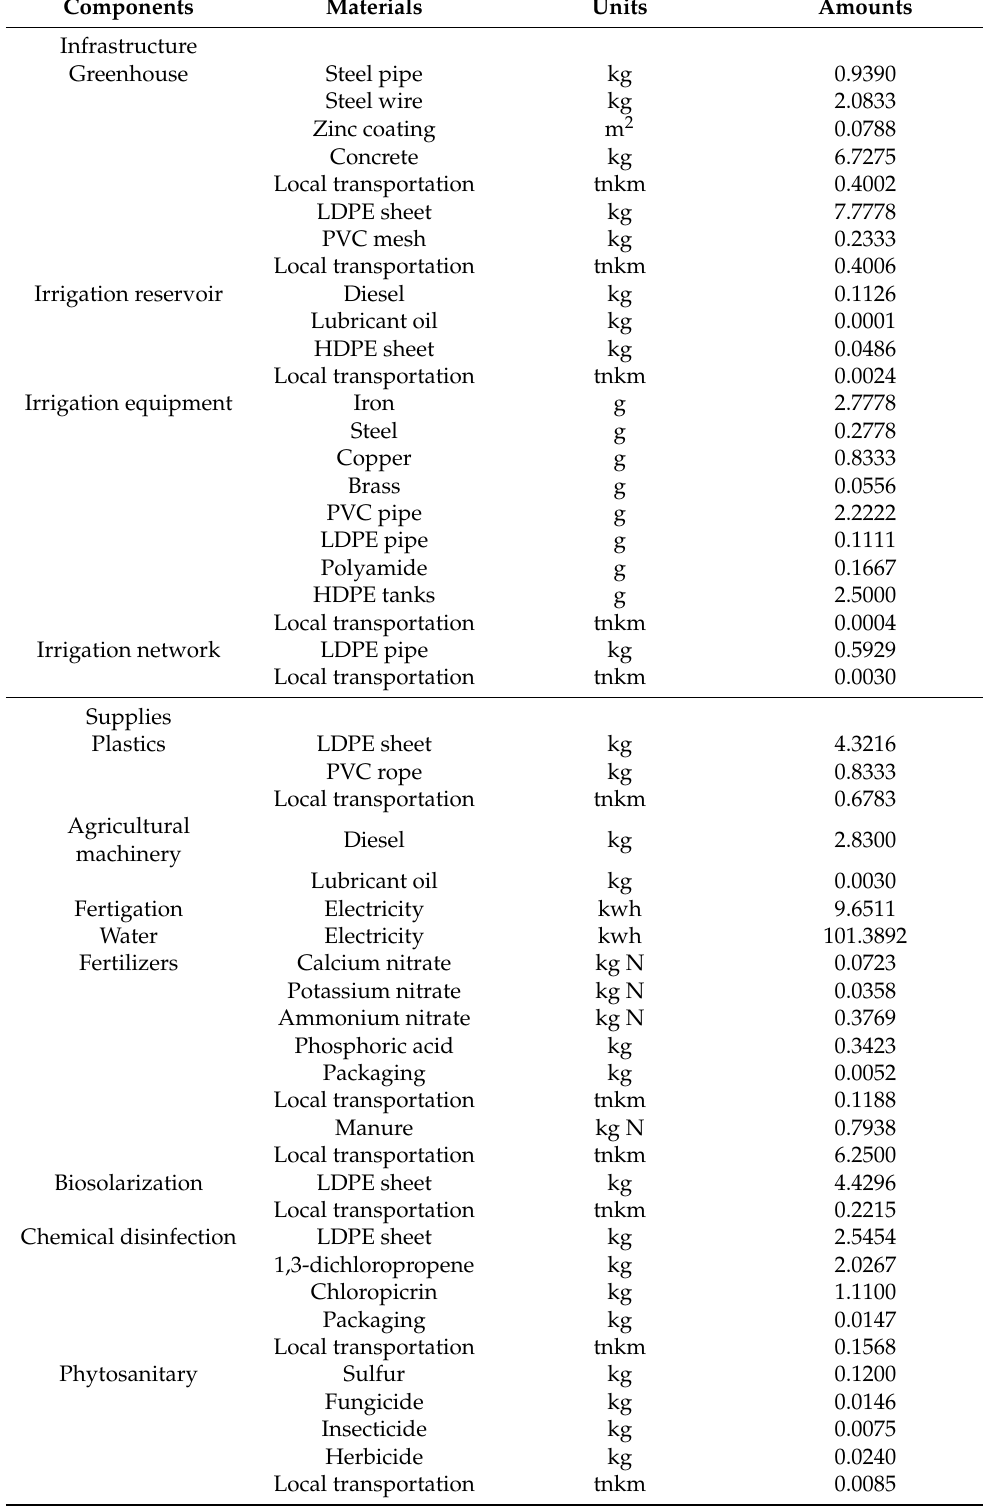
Table 2. Inputs. Functional unit: 1 t of peppers. For the infrastructures, the useful life is taken into